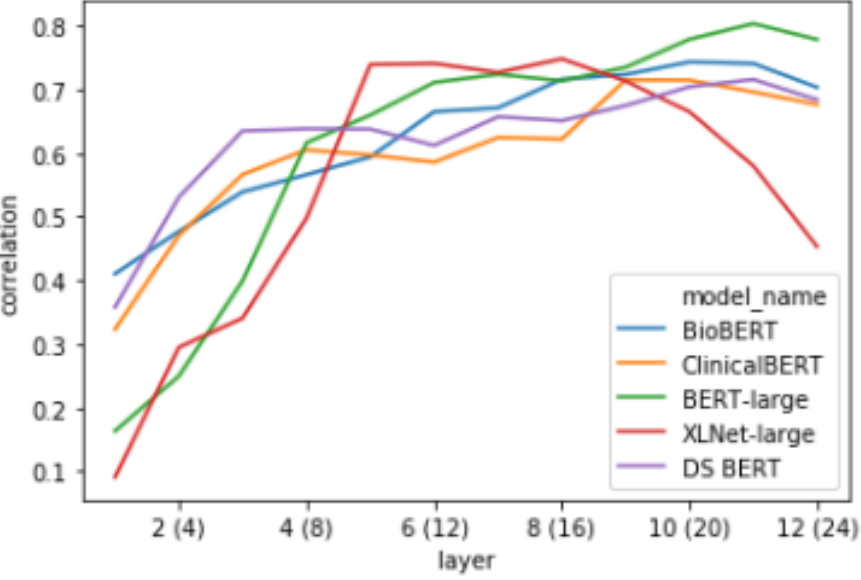
Figure 5. Pearson correlation between linear regression models’predictions of a sentence pair’s semantic similarity and the ground-truth score (10-fold